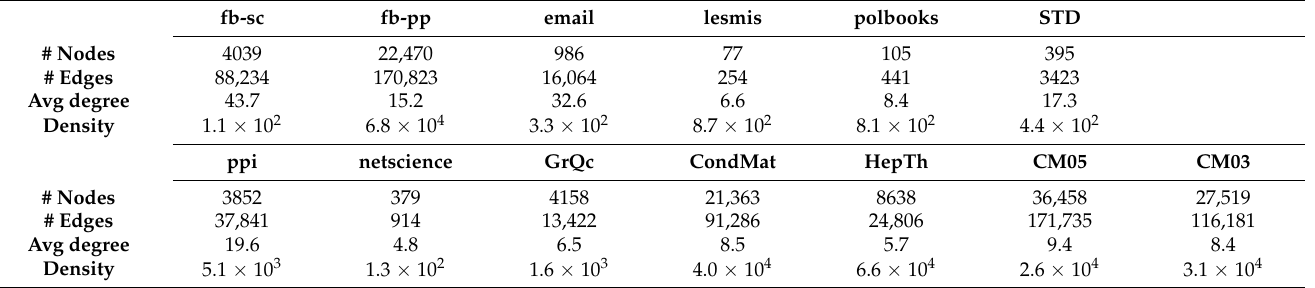
Table 2. Various properties of each semi-synthetic network used in our experiments. fb-sc